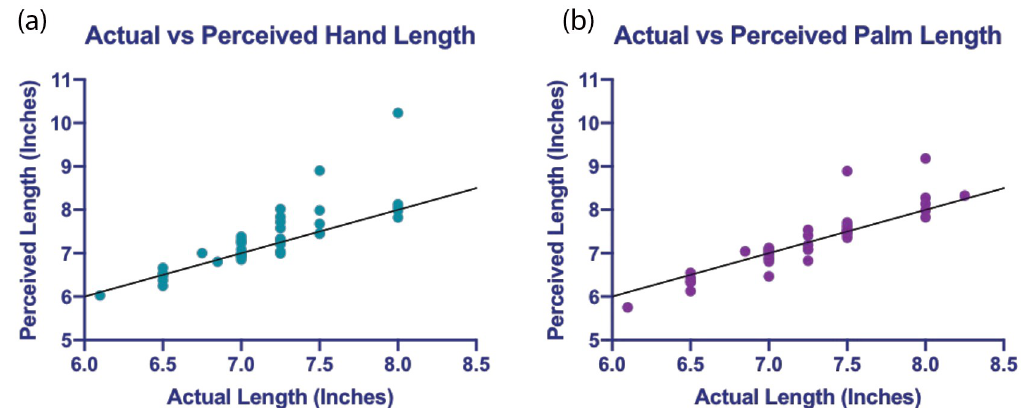
Fig 5. Actual vs perceived length. Relationship between actual and perceived lengths for (A) dorsum length and (B) palm length. The line plotted through the data represents accurate perception.